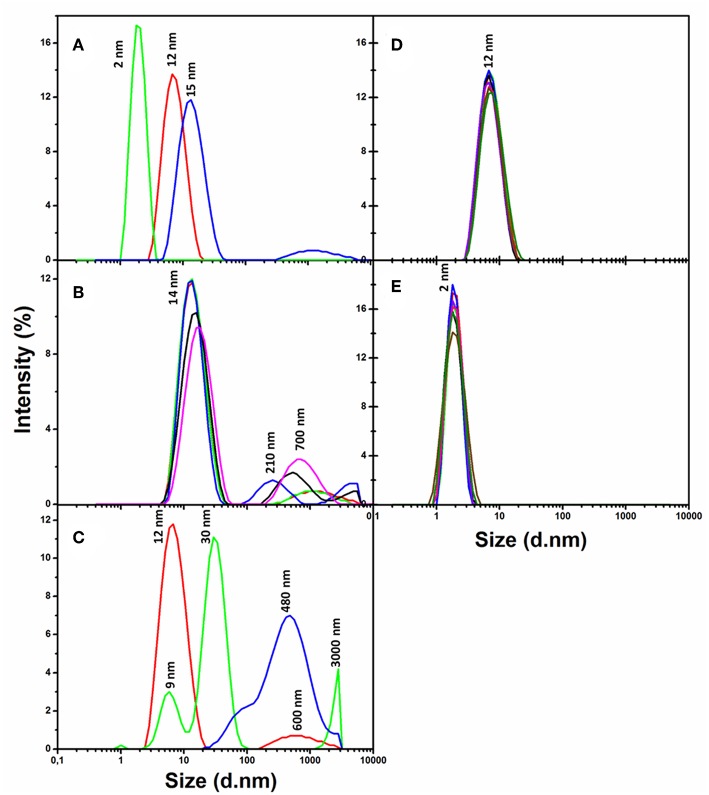
Variation of the size distributions of nanoparticles, human insulin, and nanoparticle–insulin complexes as estimated from the dynamic light scattering (DLS) spectra. (A) The DLS spectra of insulin protein alone (green), PEG-OH-modified CdSe/ZnS QDs with a core diameter of 3.1 nm (Table 1) alone (red), and a freshly prepared mixture of insulin with QDs (blue) recoded immediately after mixing of insulin and the QDs. Human insulin (2 mg/ml) was incubated in the presence of QDs (3.44 μM) in a 10 mM sodium phosphate buffer solution (pH 7.0) at 37°C. (B) The same QD–insulin mixture as in (A) where the DLS spectra were recorded after 0 (red), 5 (green), 10 (blue), 20 (black), and 30 min (magenta) of incubation. (C) The same QD–insulin mixture as in (A) where the DLS spectra were recorded after 0 (red), 12 (green), and 24 h (blue) of incubation. (D) Control experiment: a QD solution (3.44 μM) alone was incubated during 7 days in a 10 mM sodium phosphate buffer solution (pH 7/0) at 37°C. DLS spectra were recorded after 0 (red), 1 (green), 2 (blue), 3 (black), 4 (violet), 5 (rose), 6 (brown), and 7 (dark green) days of incubation. (E) Control experiment: a human insulin solution (2 mg/ml) alone was incubated in a 10 mM sodium phosphate buffer solution (pH 7.0) at 37°C, and the measurements were done at the same time points as in (D).